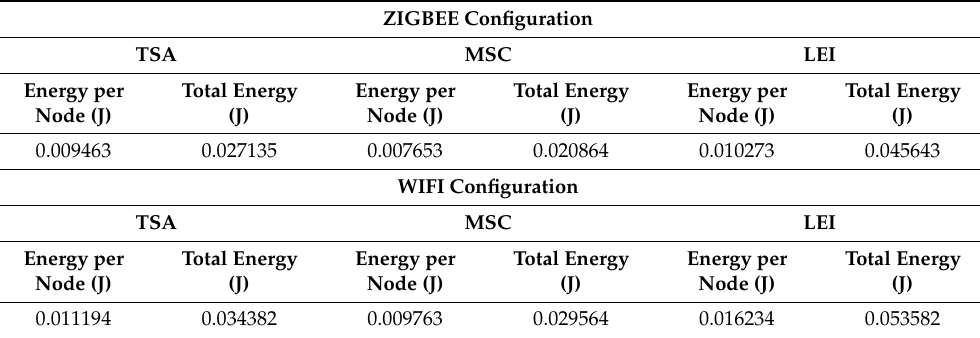
Table 9. Energy behavior per each studied algorithm under AODV protocol.